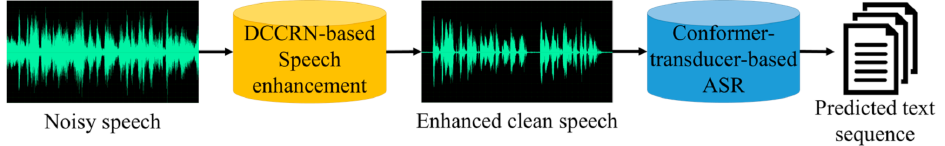
Figure 3. Block diagram of the noise-robust ASR used in this